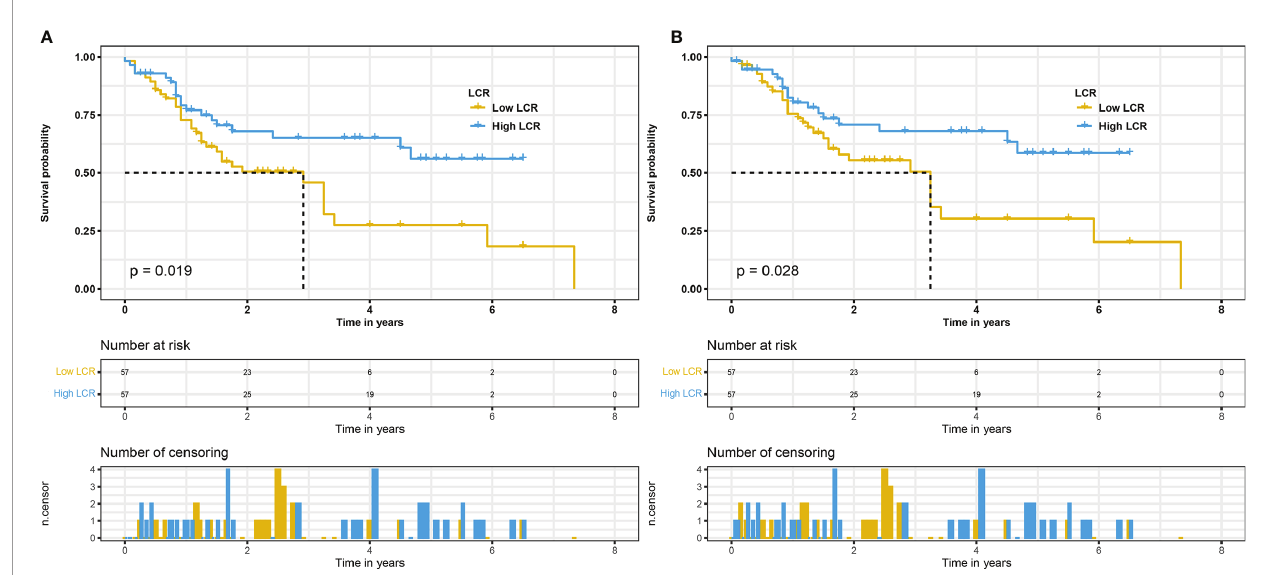
FIGURE 6 | Kaplan – Meier curves for OS in patients with radical cystectomy strati fi ed based on LCR after propensity score matching (A) . Kaplan – Meier curves for DFS in patients with radical cystectomy strati fi ed based on LCR after propensity score matching (B) . OS, overall survival; LCR, lymphocyte – C-reactive protein ratio; DFS, disease-free